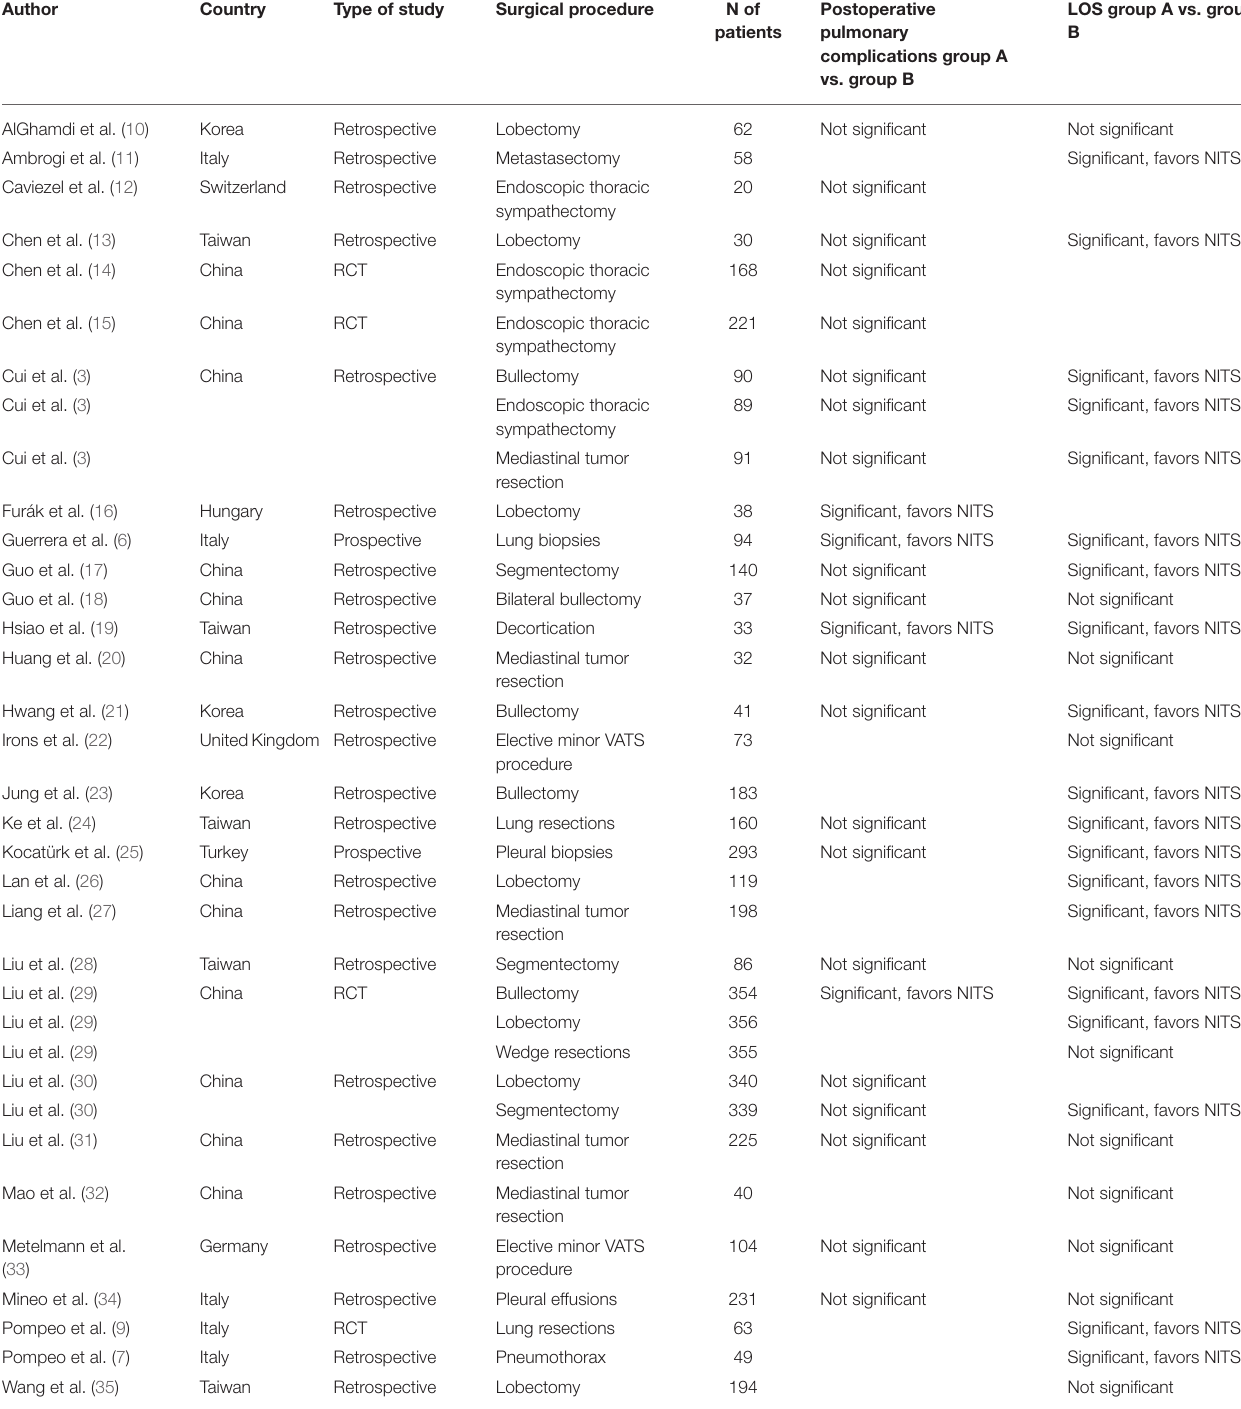
TABLE 2 | Summary table of population characteristics of cohort